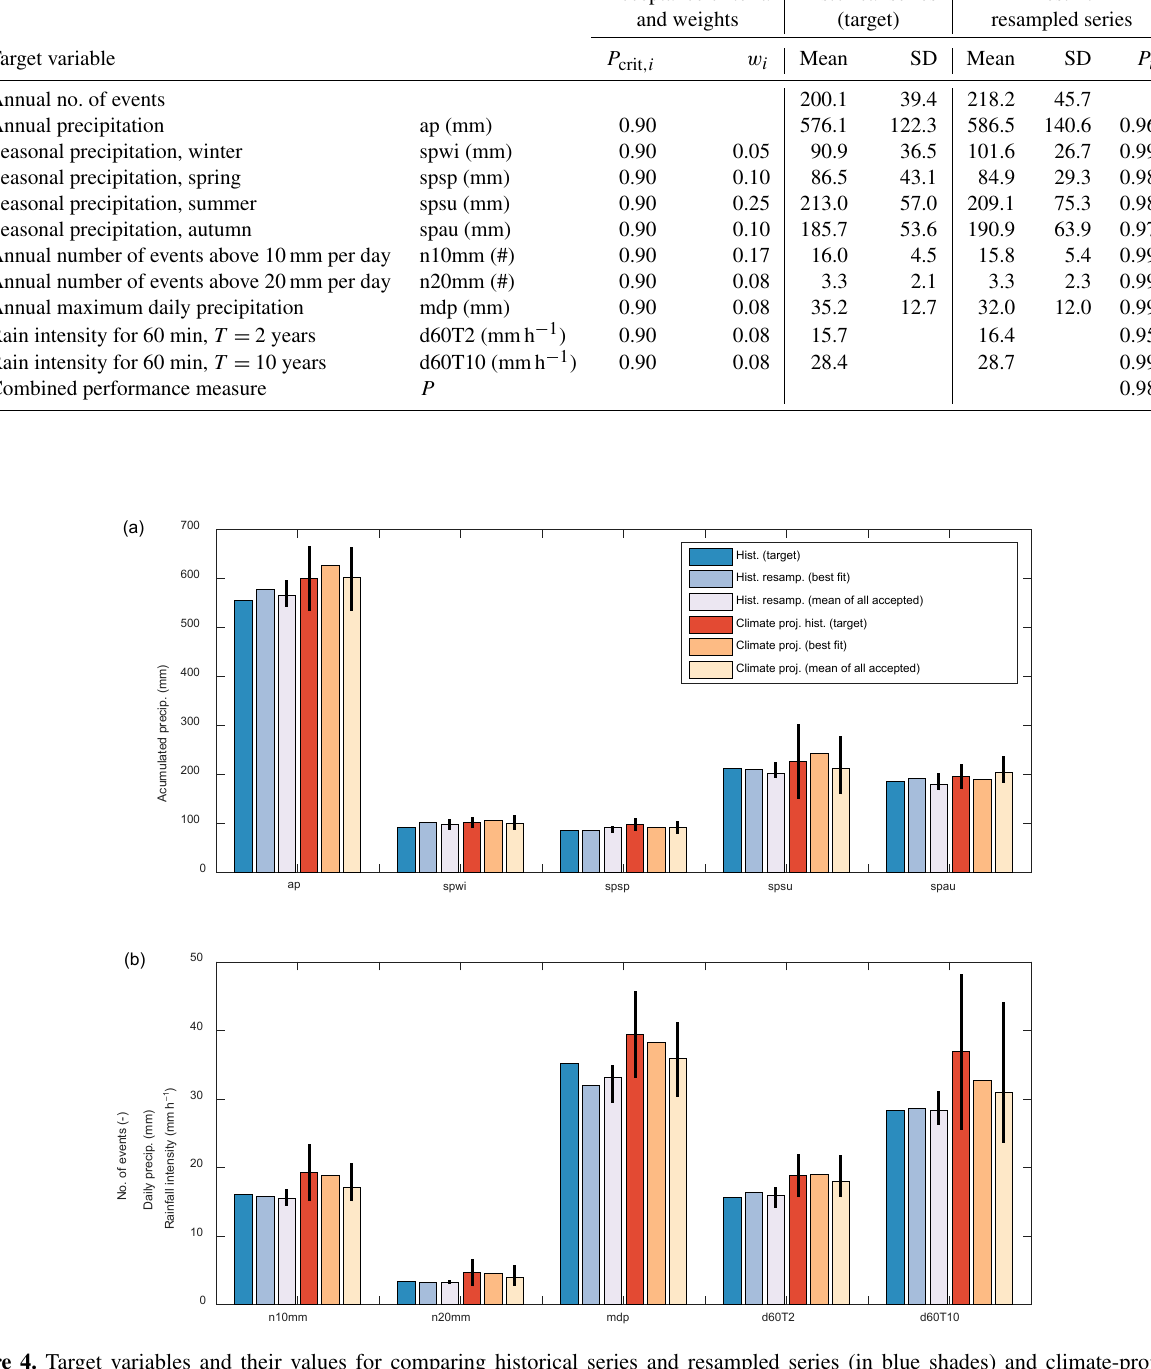
Figure 4. Target variables and their values for comparing historical series and resampled series (in blue shades) and climate-projected historical series and climate-projected and resampled series (in red shades). For the climate-projected target (deep red) the uncertainty bounds (black lines) represent 2 times the standard deviation of Tables 1 and 2. For the resampled series the uncertainty bounds represent the total range of the accepted